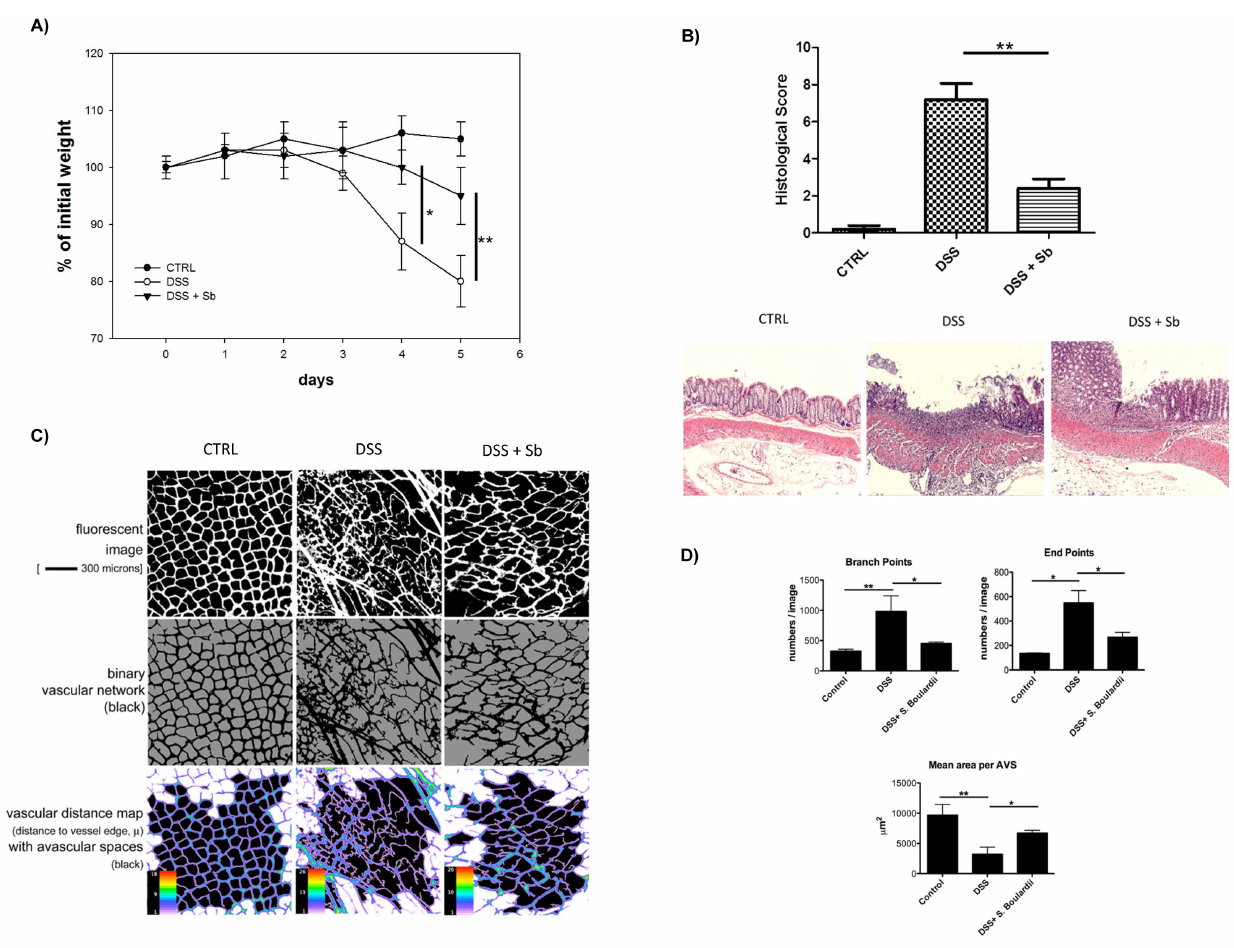
Figure 1. Oral administration of Sb reduced DSS-colitis induced weight loss, histological damage and neo-vascularization in mouse colon. We used the murine DSS-colitis model to assess the effect of Sb on neo-vascularization in acute colitis. We administered DSS (4% for 5 days) to mice to induce colitis. 1A) Daily administration of Sb by gavage significantly attenuated weight-loss (N=5, *p , 0.05, **p , 0.01). Data points represent mean relative weight 6 standard error. 1B) Histological scores for several parameters of colonic inflammation on Day 5 were evaluated [control (N=5), DSS alone (N=5), DSS plus Sb (N=5)]. Data points represent mean score 6 standard error, ** , p , 0.01. Representative H/E stained colonic images are listed. 1C) Confocal fluorescence images of the colonic microvasculature were taken 10 minutes after i.v injection of Alexa 647 WGA. Three dimensional image reconstructions were translated into two dimensional grayscale images and binarized to black-and-white vascular patterns for analysis using VESGEN software. Representative images are shown. 1D) Quantitative data are presented in Tables 1 and 2. Comparisons of vascular network and avascular space indices among control, DSS and DSS + Sb groups. Compared to control mice, the DSS group had significantly increased numbers of branch points and density of vessel endpoints (p=0.004, p=0.02 respectively). Sb treatment significantly reduced these DSS effects (p=0.045, p=0.02 respectively). The mean area per AVS ( m m 2 ) in the lamina propria was reduced in the DSS group compared to the control group (p=0.01). Sb treatment normalized this effect (p=0.02).